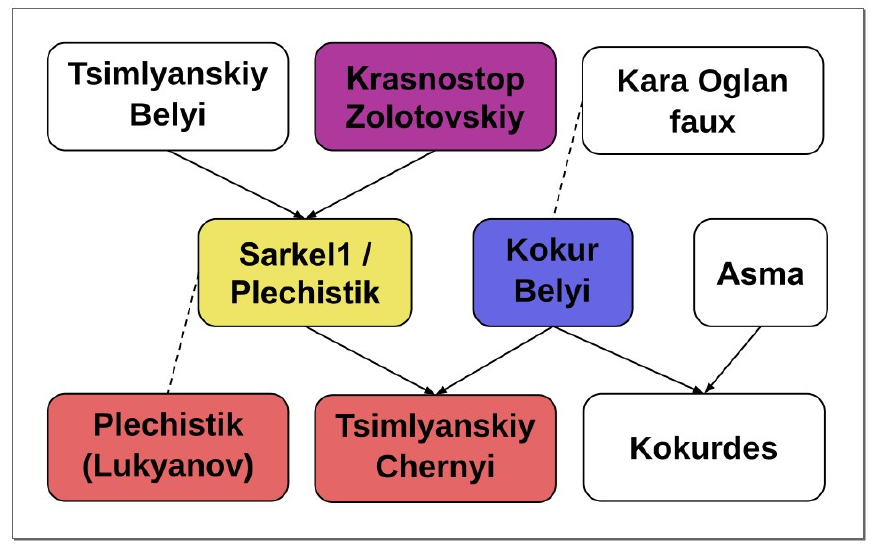
Figure 1. Predicted parent–offspring relations of Russian grape cultivars. White rectangles-data from Lacou et al., 2018. Coloured rectangles-data from the current study. Colors correspond sampling locations from Figure 1. Arrows show directed parent-to-offspring relations, dashed lines show undirected parent–offspring relations.